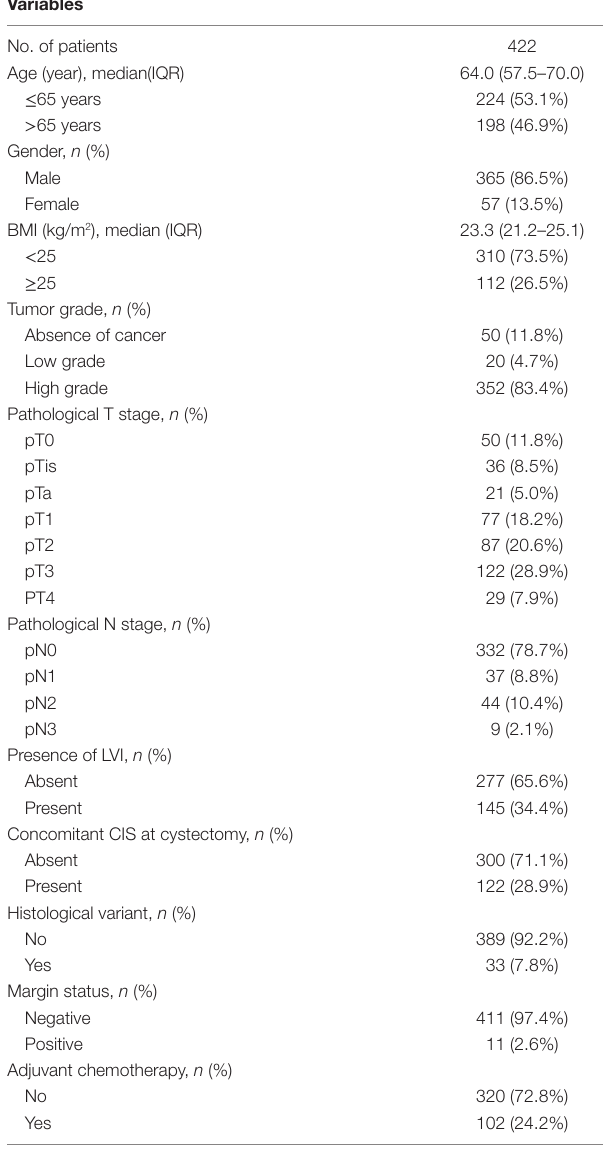
TaBle 1 | Baseline characteristics of the study